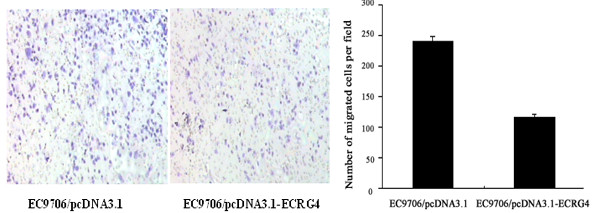
Effect of ECRG4 overexpression on tumor cells migration. Representative photos and statistic plots of migration assay in EC9706/pcDNA3.1-ECRG4 and EC9706/pcDNA3.1 cells (×200). The number of EC9706/pcDNA3.1-ECRG4 cells transversed the Transwell membrane was decreased compared with that of EC9706/pcDNA3.1 cells (P < 0.05). Error bars represent standard deviation from mean value.